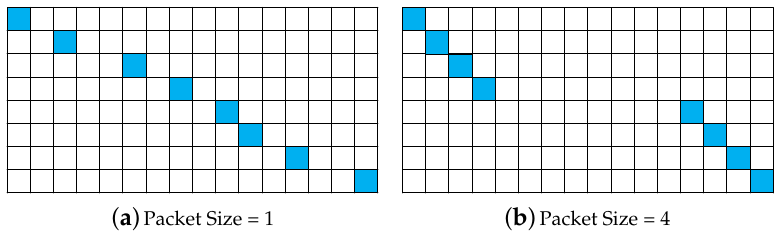
Figure 6. Examples of the passive CS measurement matrix under different packet sizes, with blue grids denoting one and blank grids denoting